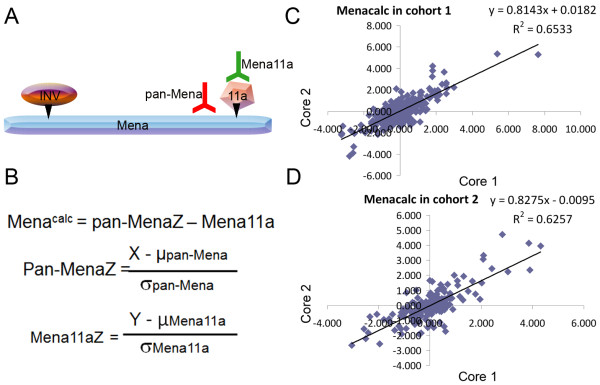
Generation of Menacalc scores and assessment of tumor heterogeneity in two independent breast cancer cohorts. A. Schematic representation of Mena, alternatively spliced inclusion of exons for Mena isoforms and binding sites for pan-Mena and Mena11a antibodies. B. Equation for the calculation of Menacalc scores and equations used to calculate Z scores for pan-Mena and Mena11a. × is the AQUA score for pan-Mena, Y is the AQUA score for Mena11a, μ is the mean of the AQUA scores for pan-Mena or Mena11a in each independent cohort and σ is standard deviation for pan-Mena or Mena11a AQUA scores for each independent cohort. C, D. Tumor heterogeneity of Menacalc in two independent cores of 501 individual patients from Cohort 1 (C) and 296 patients from Cohort 2 (D).